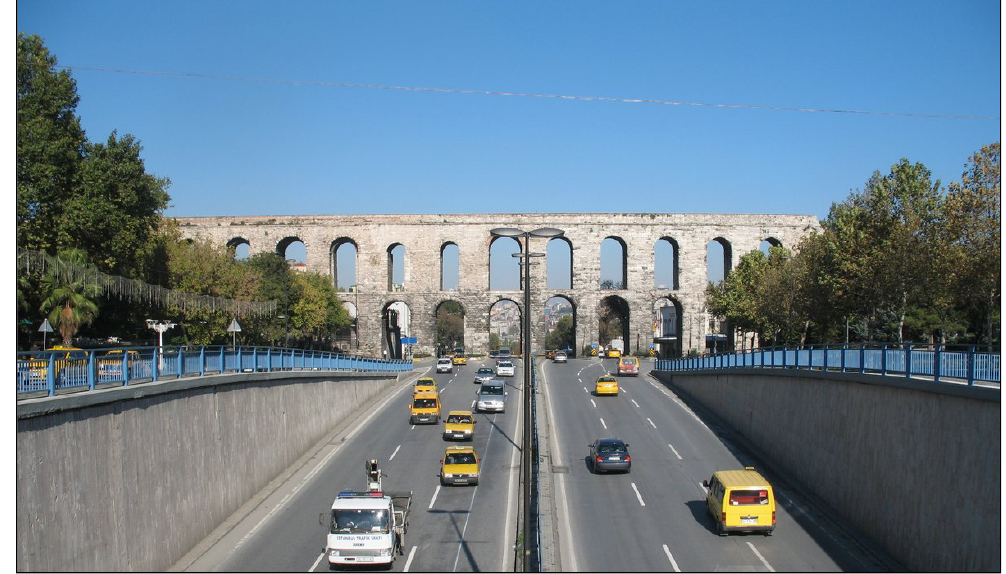
Figure 15. The Valens Aqueduct of Constantinople (image in the public